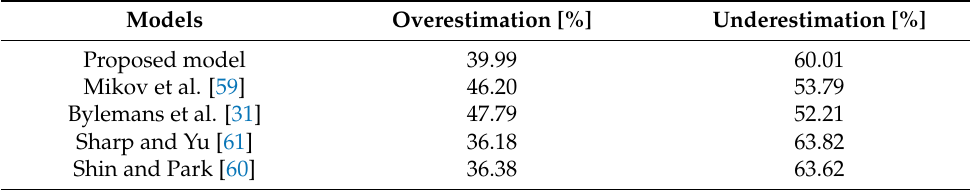
Table 4. Percentage shares of overestimated and underestimated strides